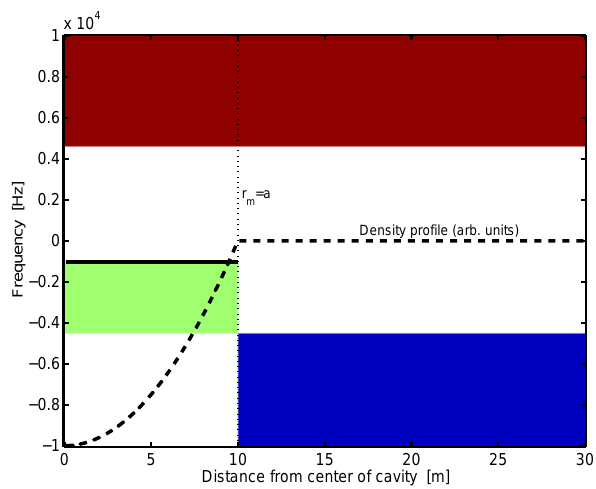
Fig. 1. The coloured areas give the regions where waves may exist (Eq. (26)). The cavity has in this example the parabolic shape used by Schuck et al. (1998), given in Eq. (25). Here we have used 1 = 0 . 35, a = 10m, m = 1 and k z = 0 . 003m − 1 . We have also assumed the ions to be oxygen ions, and f LH = 4600Hz and f ce = 8 × 10 5 Hz. Positive frequencies correspond to waves rotat- ing in the right-handed direction with respect to the magnetic field, while negative frequencies indicate left-handed rotation. The solid black line is the limiting frequency, ω m /( 2 π) , given by Eq. (27). The density profile is also included for